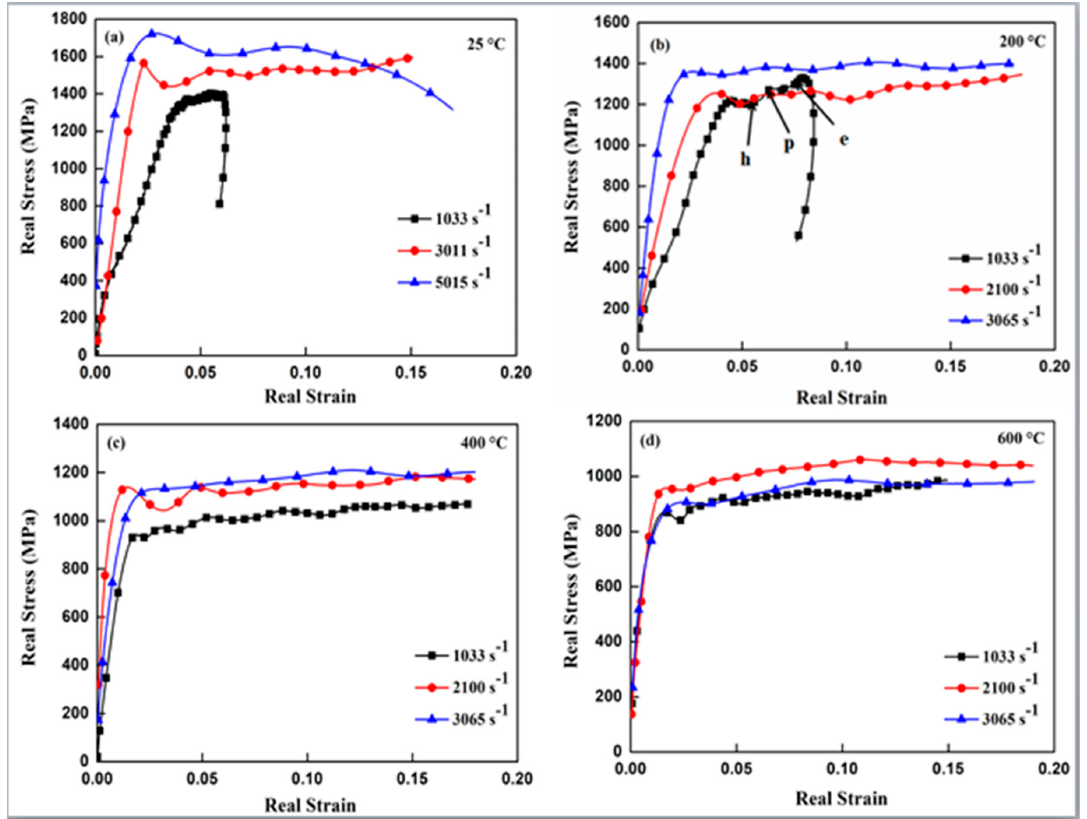
Figure 10. Stress–strain curve of TC18 alloy at the same temperature and different strain rates (( a ) shows the stress–strain curves of different strain rates at T = 25 °C, ( b ) shows the stress–strain curves of different strain rates at T = 200 °C, ( c ) shows the stress–strain curves of different strain rates at T = 400 °C, and ( d ) shows the stress–strain curves of different strain rates at T = 600 °C).